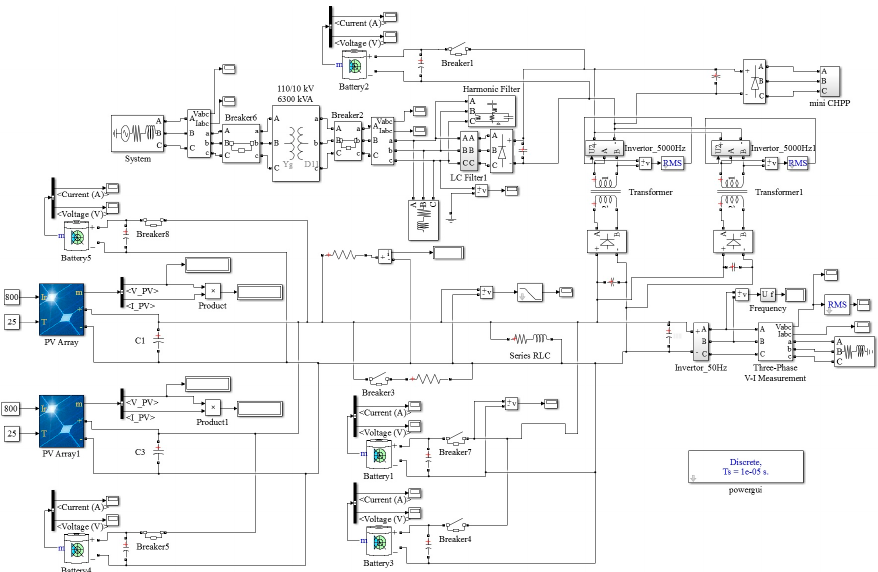
Figure 5. Flow chart of the MATLAB model of the investigated power router-based grid. The flow chart of the mini CHPP model is shown in Figure 6. The mini CHPP tur- bine generator was modeled with Synchronous Machine pu Fundamental, a standard block of the SymPowerSystems library of the MATLAB environment. The structural di- agram of the adopted steam turbine model with intermediate steam extraction (Steam turbine block in Figure 6) is shown in Figure 7. For the thyristor exciter (Exciter block in Figure 6), we used a model of a first-order aperiodic link with the coefficient k e = 1, time constant T e = 0.025 s, and a voltage limiting block [40]. Regulation of rotor speed and turbine generator voltage was performed using models of automatic regulator of speed (ARS) (the Automatic regulator of rotor speed block in Figure 6) and automatic regulator of excitation (the MARE block in Figure 6), which are proportional-integral-differential (PID) regulators described by the following transfer functions: 1)